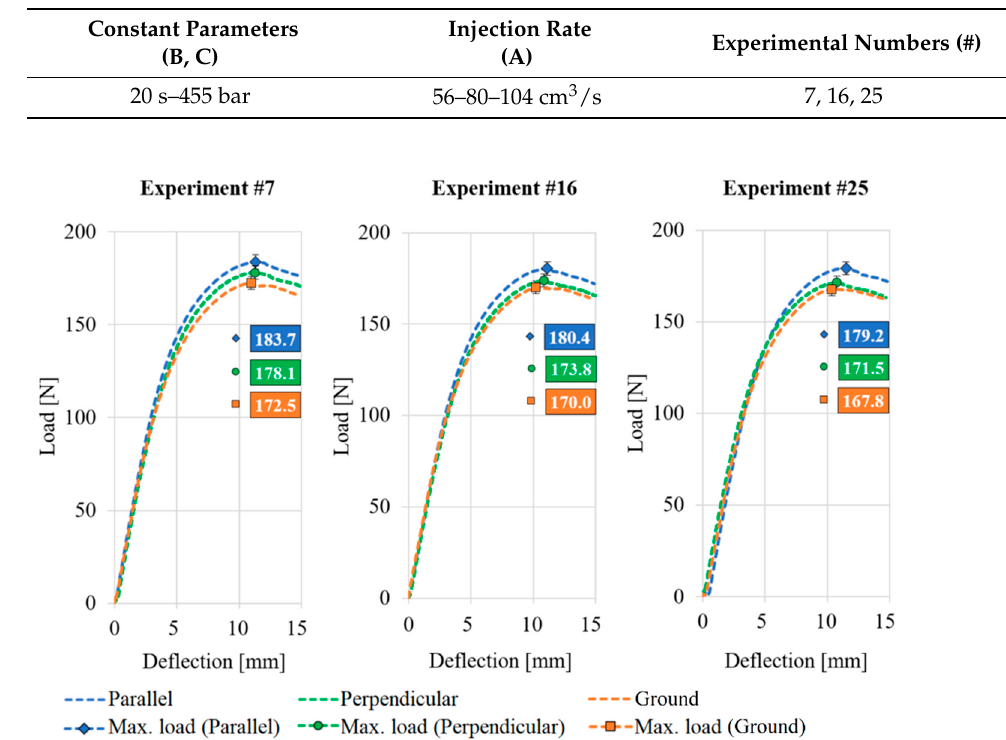
Figure 7. Bending diagrams of specimens made by perpendicular and parallel surface-structured and ground mold inserts. and ground mold